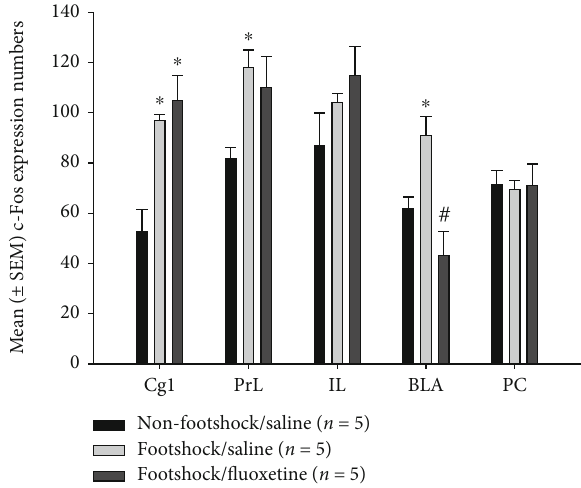
Figure 4: The mean ( ± SEM) c-Fos-positive neurons per slice in nonfootshock/saline, footshock/saline, and footshock/ fl uoxetine groups ( n = 5 , per group). The number of c-Fos-positive neurons was counted in the amelioration of fl uoxetine for PTSD-associated regions, including the Cg1, PrL, IL, BLA, and